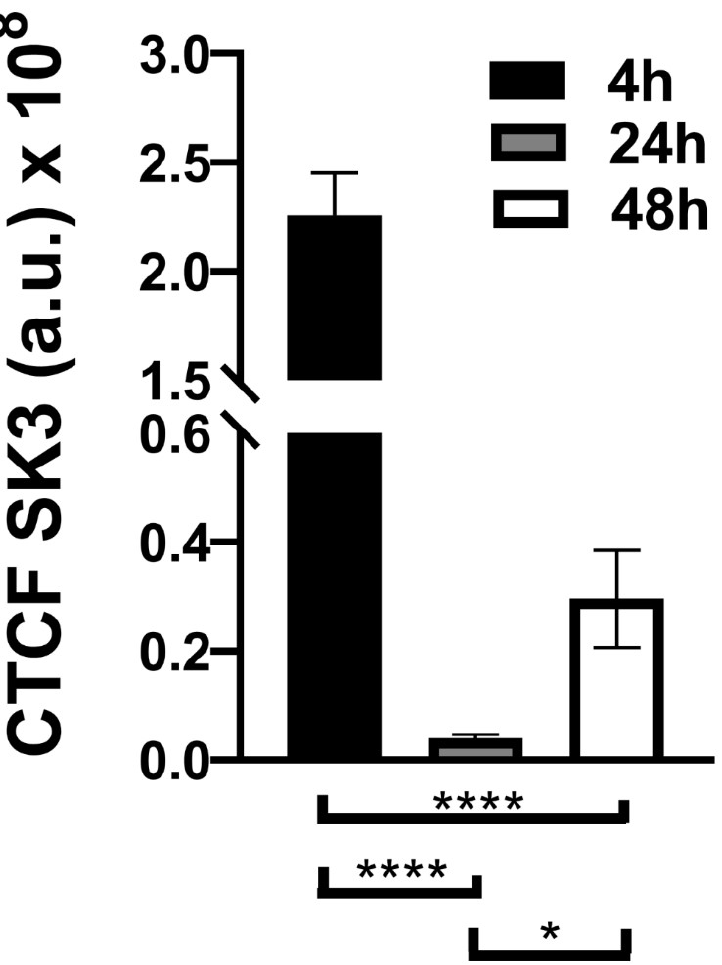
Figure 10. SK3 fluorescence quantification at each time point (4 h, 24 h, and 48 h). * p < 0.05, **** p < 0.0001.